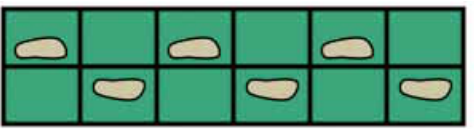
Figure 5-24. Rope or Ladder Routine – Every Other Hole